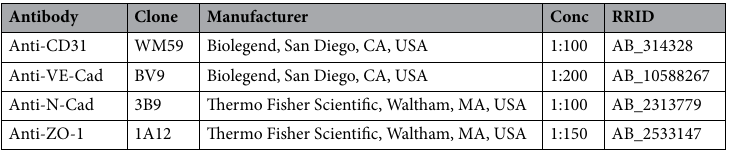
Table 1. Antibodies used for immunohistological